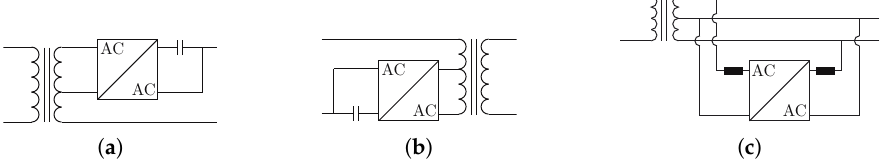
Figure 4. Additional HDT configurations. ( a ) Series connection to the high voltage taps. ( b ) Series connection to the low voltage taps. ( c ) Shunt connection to both phases of a single-phase with central tap